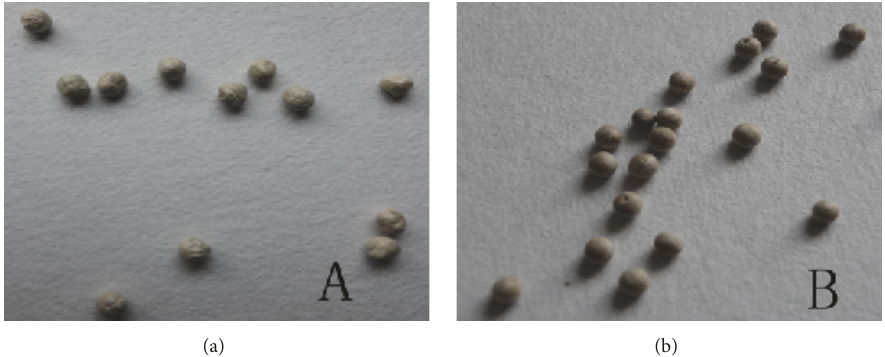
Figure 6: The morphology of spherical biocarriers before (a) and after 15 days (b) suspended in pH 7.4.